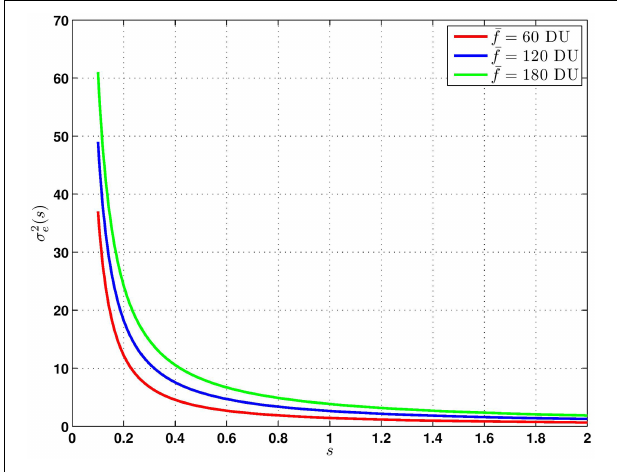
FIGURE 6 | Representation of FPAs with rectangular (left) and circular (right) active area detector